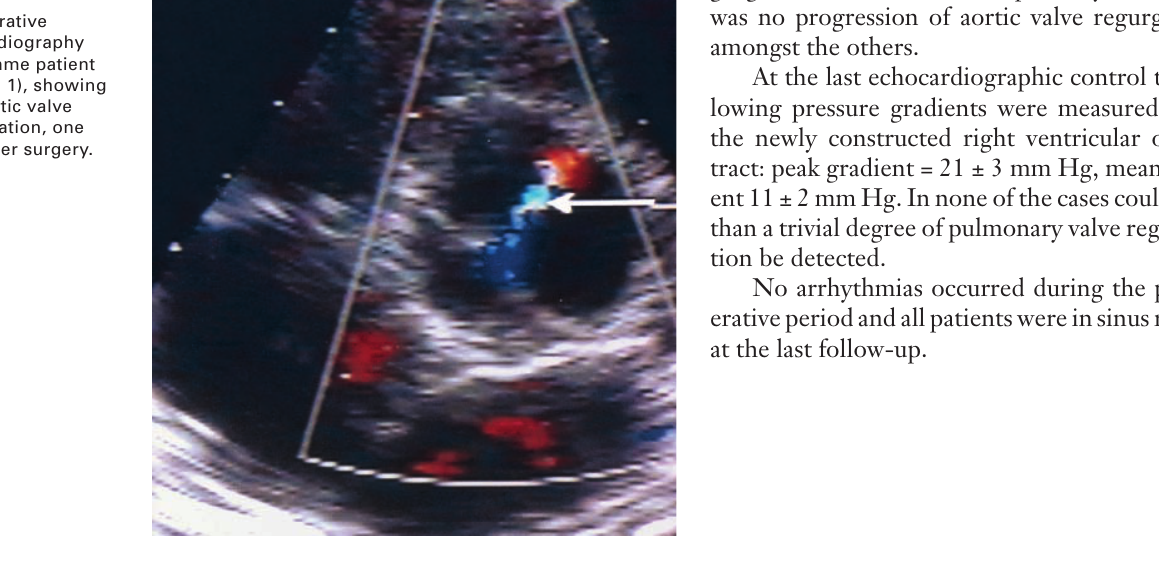
Figure 2 Postoperative echocardiography of the same patient (see Fig. 1), showing mild aortic valve regurgitation, one week after